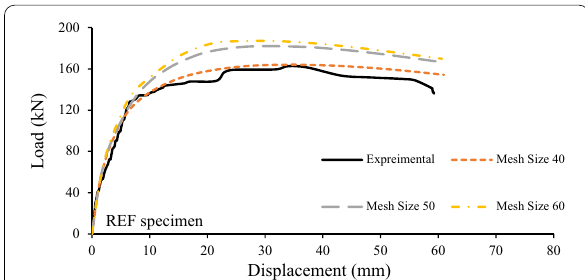
Fig. 24 Mesh sensitivity analysis results for the reference specimen with three mesh sizes of 40, 50 and 60